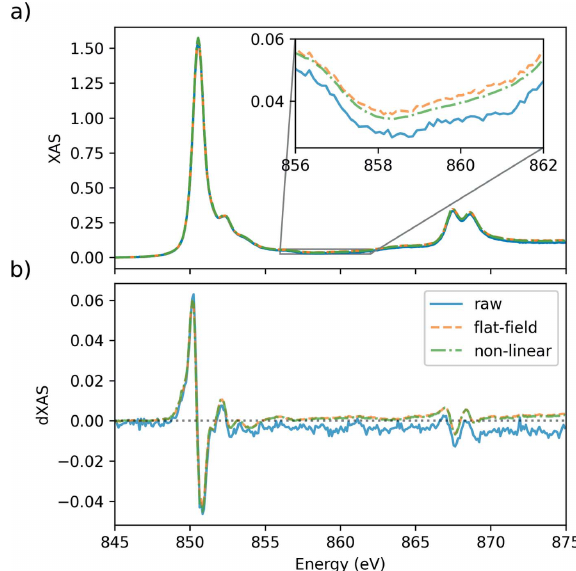
Figure 9 ( a ) XAS and ( b ) transient change in XAS at the Ni L 3,2 edges of a NiO thin film. The data were recorded at a fixed time delay of 1.0 ps, with a peak fluence of 5 mJ cm (cid:2) 2 and a pump wavelength of 266 nm. Data that are only dark-corrected are shown as continuous blue lines and labeled ‘raw’. Data that are additionally flat-field corrected are shown as dashed orange lines and labeled ‘flat-field’. Data that are also corrected for non- linearity are shown as dot-dashed green lines and labeled